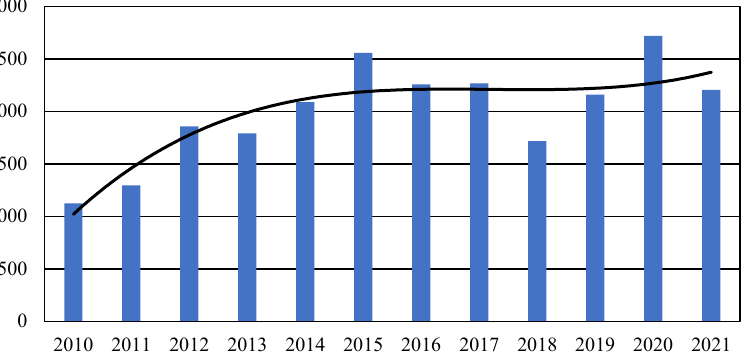
Figure 2. The potential of by-products of crop production used for conversion in Lithuania (thous. t.).